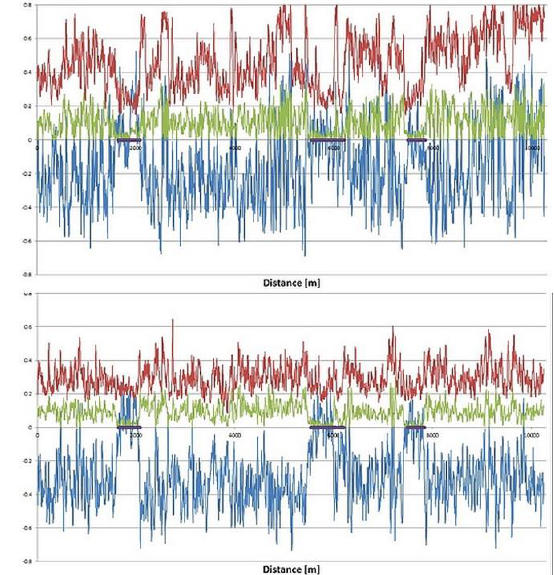
Figure 6. Transects along the white vertical lines in Figure 5; upper: June 6, lower: June 22, 2013. Blue curves correspond to the mean of a moving window of length 11, red curves to the respective standard deviation, and green curves to the absolute value of the product of both. Horizontal bars mark oyster beds This parameter, derived through a chain of simple arithmetic operations, clearly helps deriving indicators for bivalve (oysters and mussel) beds: calculated for the entire imaged area (and performing the statistical operations for a moving two- dimensional box) the resulting maps show local minima at those locations, which clearly coincide with locations of oyster beds detected during recent field campaigns (not shown herein). As an example, Figure 8 shows such a map, derived from the dual- polarization TerraSAR-X images of June 22, 2013.